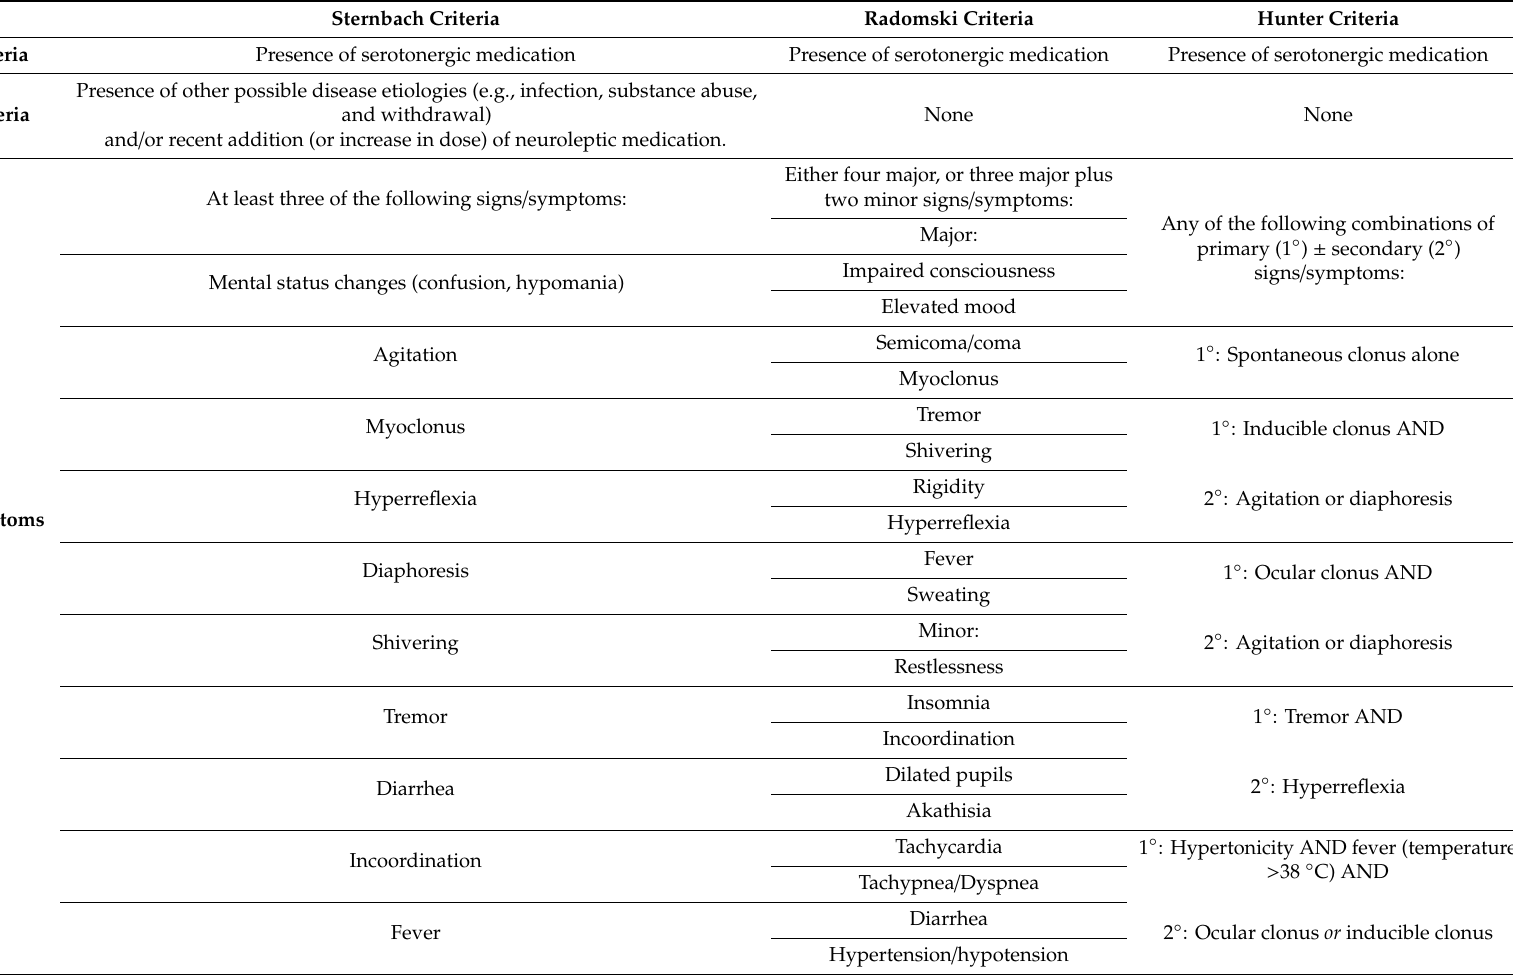
Table adapted from